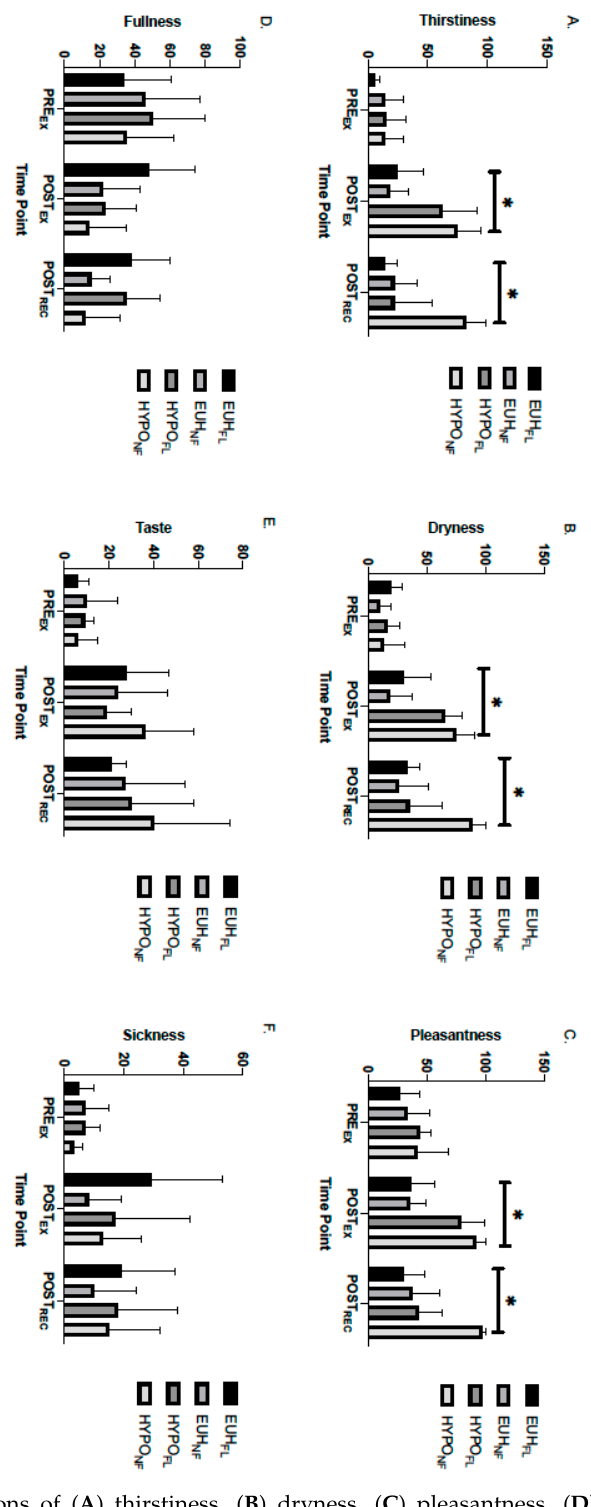
Figure 2. Perceptions of ( A ) thirstiness, ( B ) dryness, ( C ) pleasantness, ( D ) fullness, ( E ) taste, and ( F ) sickness in EUH FL EUH NF HYPO FL and HYPO NF groups. * indicates a significant difference between the HYPO trial (HYPO FL and HYPO NF ) and EUH trial (EUH FL and EUH NF ); p < 0.05. EUH FL = minimized fluid losses during exercise and remaining losses replaced during recovery; EUH NF = minimized fluid losses during exercise and did not replace losses during recovery; HYPO FL = fluid restricted during exercise and losses replaced during recovery; HYPO NF = fluid restricted during exercise and losses not replaced during recovery.